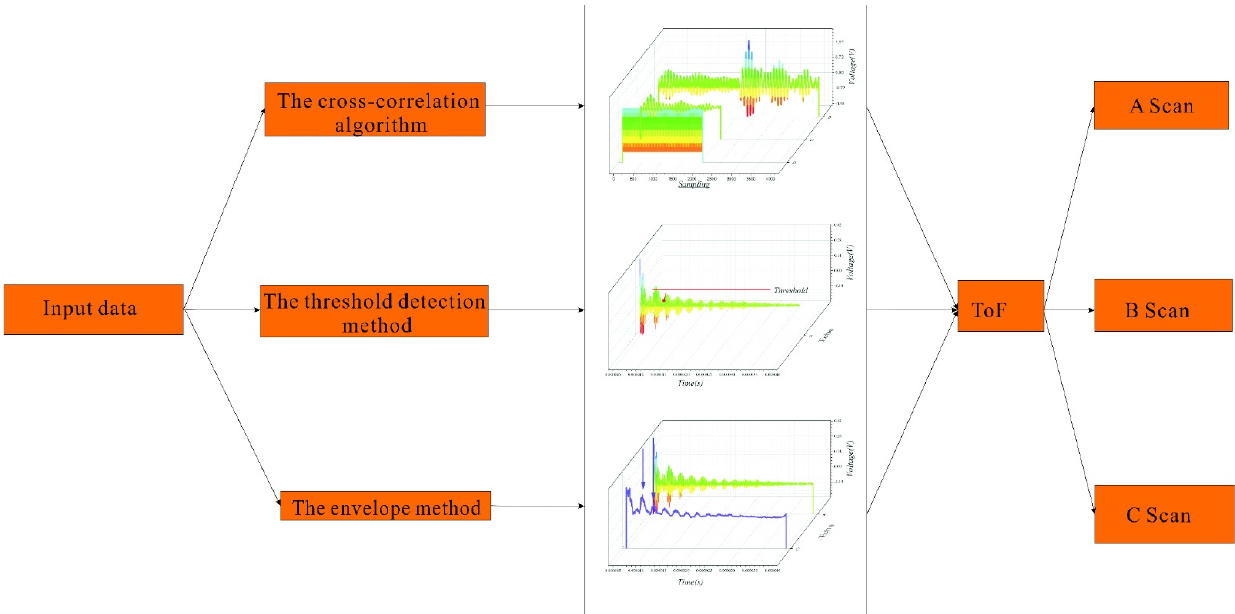
Figure 3. ToF evaluation process and application(Violet line represents the signal envelope; Colorful lines represents echo signal).